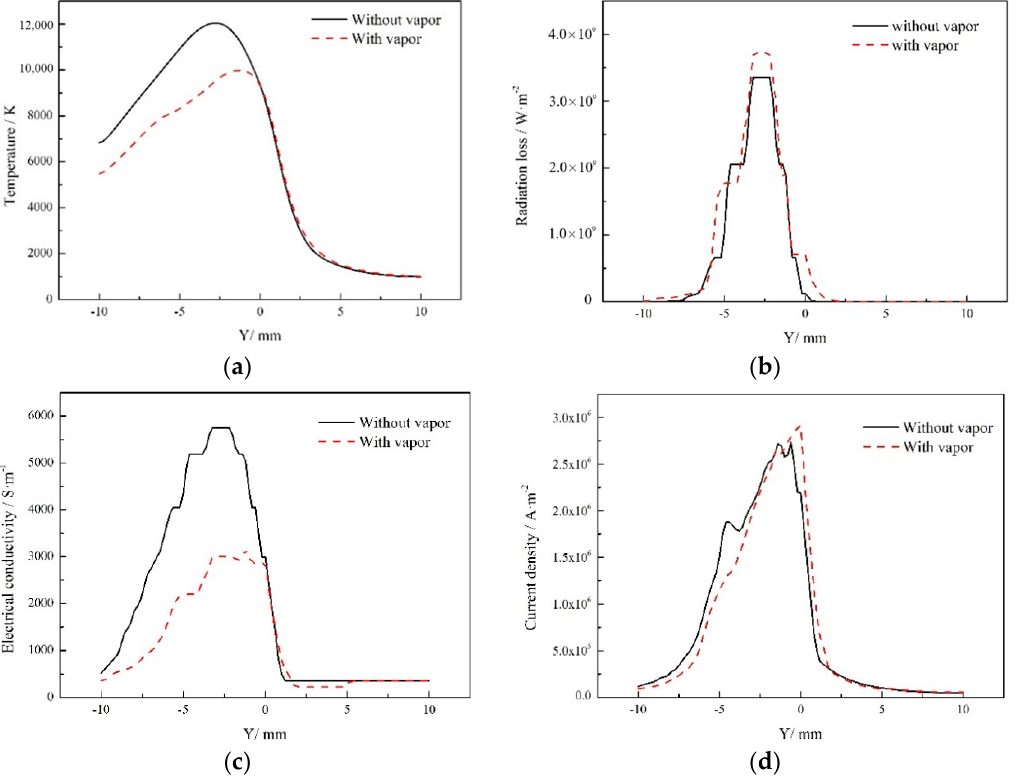
Figure 17. Influence of the metal vapor on arc characteristics: ( a ) temperature, ( b ) radiation loss, ( c ) electrical conductivity, and ( d ) current density.